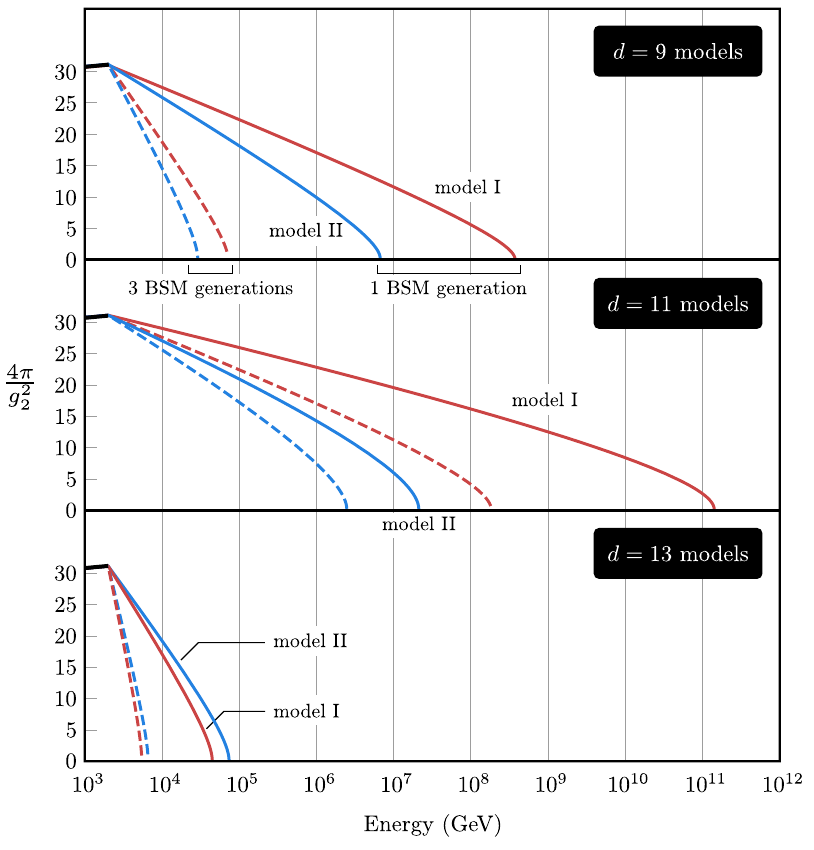
Figure 10 . Running of the (inverse of) the gauge coupling g 2 for six of the eight di(cid:11)erent genuine neutrino mass models we have found: two at d = 9, plus two at d = 11 and six at d = 13 (in this last case, we do not show the running for the two models with a fermion septet). For a summary of the (cid:12)elds in each model shown here, see appendix B. Continuous lines are for a single copy of each exotic fermion representation, while the dashed lines show the running of g 2 for three families. In all cases Landau poles appear below the Planck scale, assuming a new physics scale of 2